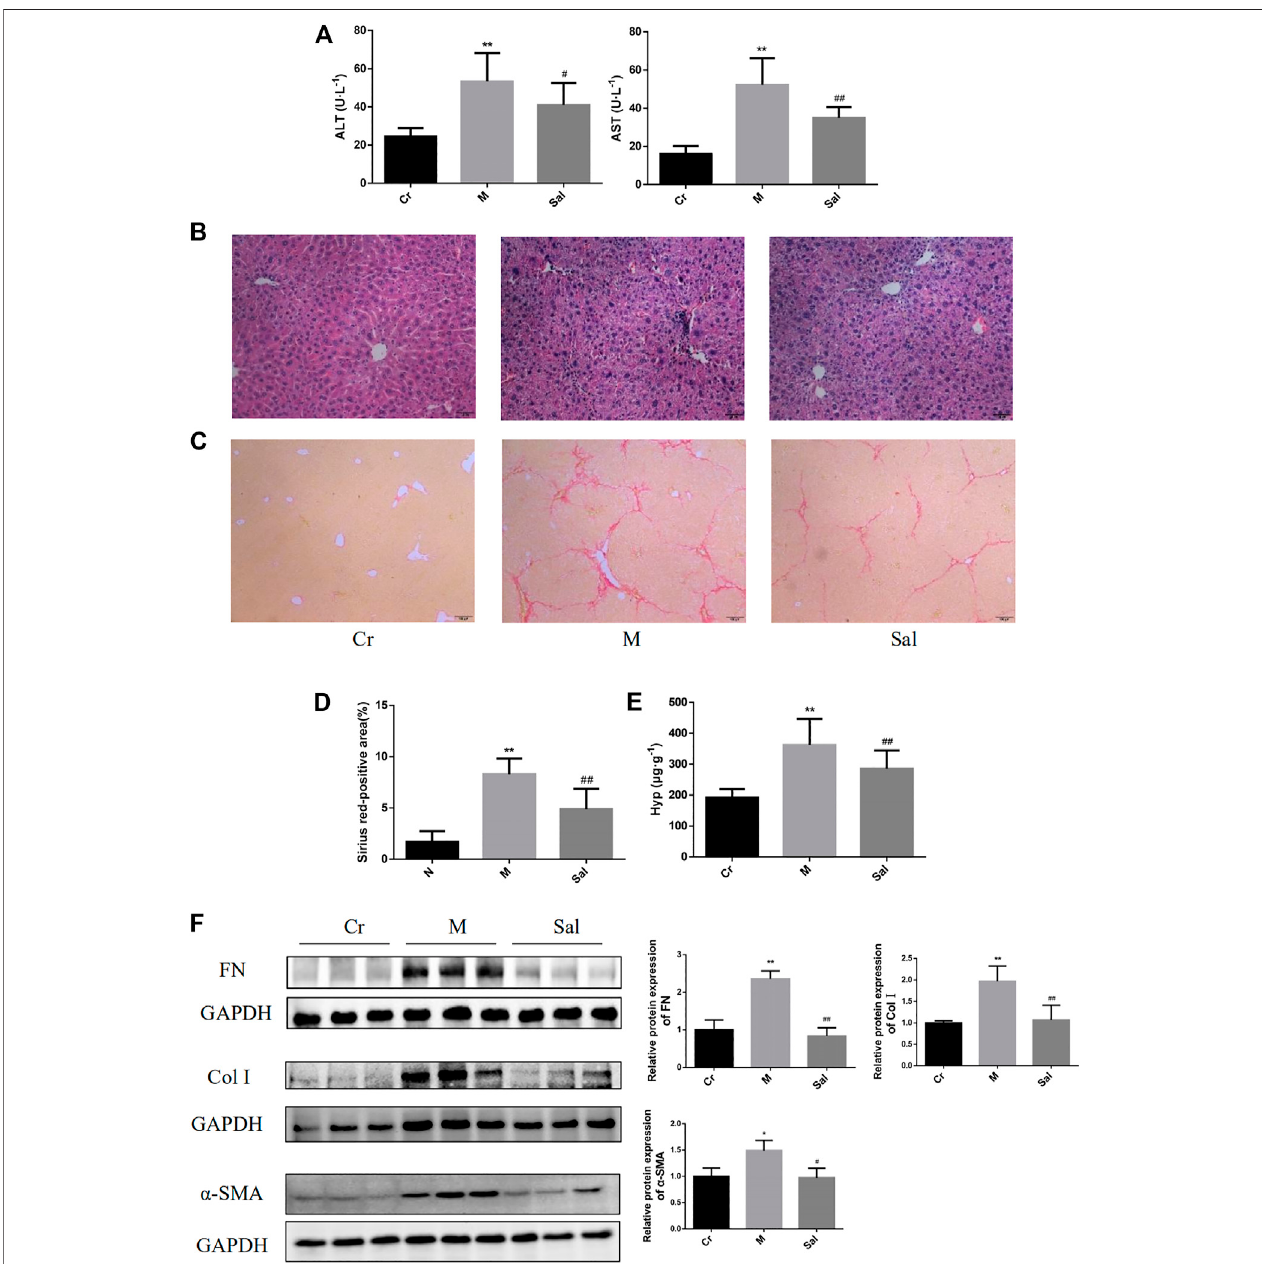
FIGURE 1 | Effects of Sal on liver injury and fi brosis induced by CCl 4 . (A) : Levels of serum ATL and AST in different groups. (B) : HE staining of liver tissues in each group ( × 100). (C) : Sirius red staining of liver tissue sections ( × 100). (D) : Sirius red-positive area. (E) : Contents of Hyp in liver tissue. ** p < 0.01, vs. Cr; ## p < 0.01, vs. M. (F) : Expressions of FN, Col I, and α -SMA in mice liver tissue were detected by WB. ( n (cid:1) 15, * p < 0.05, ** p < 0.01, vs Cr; # p < 0.05, ## p < 0.01, vs M.) ALT: alanine transaminase; AST: aspartate aminotransferase; Hyp: hydroxyproline; Cr: control group; M: model group; Sal: salidroside group. α -SMA: α -smooth muscle actin; FN: fi bronectin; Col I: type I collagen; Cr: control group; M: model group; Sal: salidroside group.